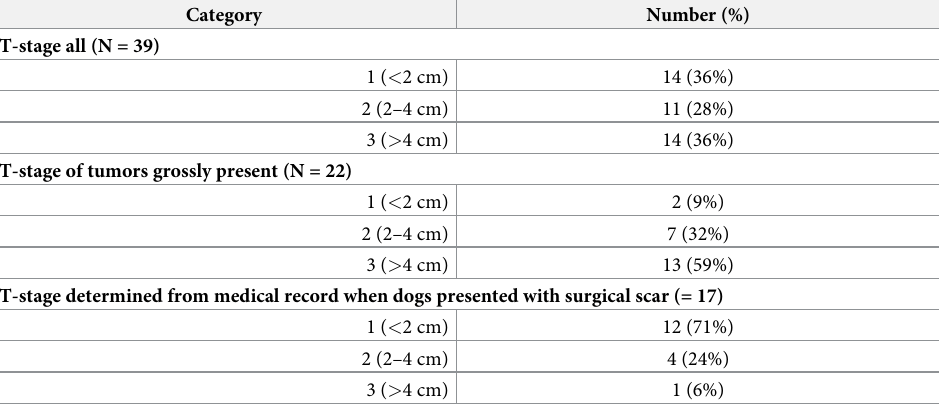
Table 4. Tumor size distribution in dogs with oral tumors.